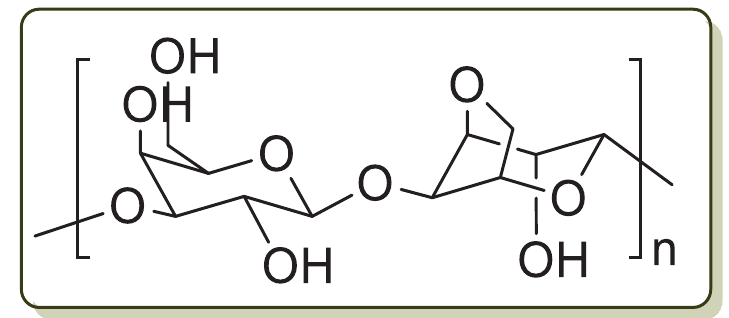
Figure 4. Chemical structure of agarose.